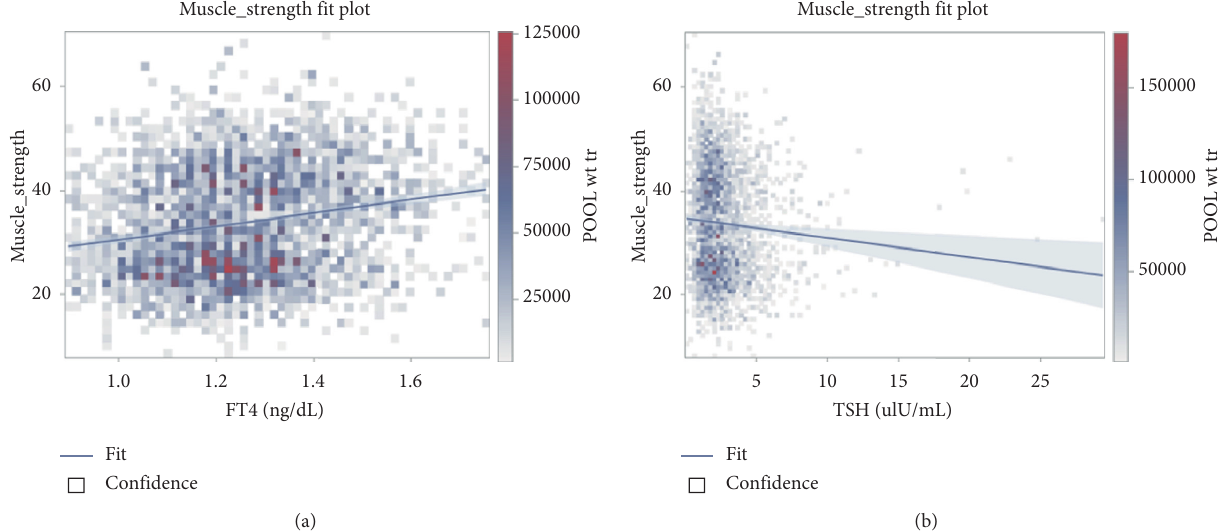
Figure 1: Univariate linear regression analyses of factors associated with muscle strength. In univariate analysis, free thyroxine (FT4) positively correlated with upper limb muscle strength ( β coefficient � − 12.84, p < 0 . 001), while thyrotropin (TSH) did negatively ( β coefficient �− 0.37, p � 0 . 002).